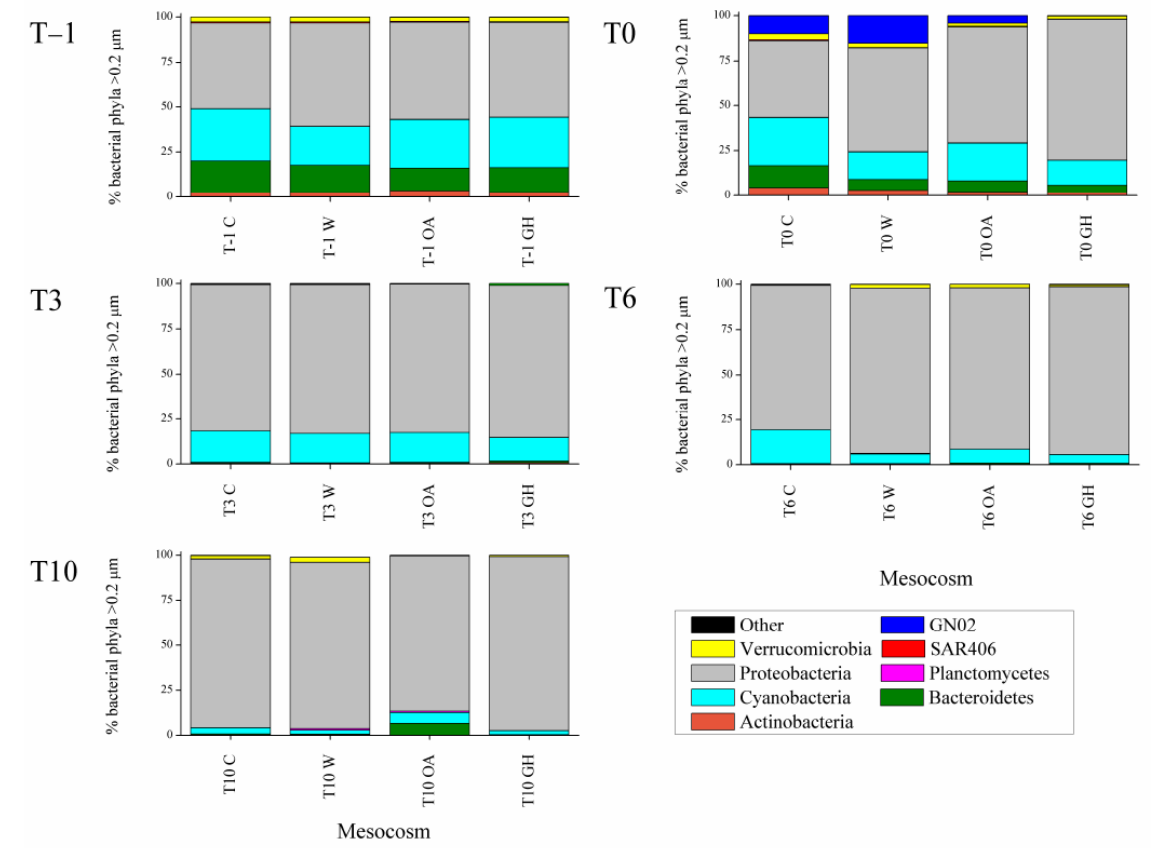
Figure 1. The abundances of ( a ) heterotrophic bacteria (cells mL − 1 ) and (( b ) Synechococcus Figure 1. Percentage contribution of bacterial phyla (>0.2 μ m fraction) in the mesocosms at T – 1, ( Synechococcus , cells mL − 1 ) in the mesocosms at T–1, T0, T3, T6 and T10. Colored asterisks above T0, T3, T6 and T10. “Other” phyla include Acidobacteria, Chlorobi, Chloroflexi, Firmicutes, Gem- symbols denote significant differences from the controls. For the treatment abbreviations, please refer matimonadetes, NC10, Nitrospirae, Spirochaetes and ZB3. C: control mesocosms, W: mesocosms to Figure 2. where the temperature was increased by 3 °C (labeled after warming), OA: mesocosms where the pH was decreased by 0.3 units (labeled after ocean acidification), GH: mesocosms where the tem- perature was increased by 3 °C and the pH was decreased by 0.3 units (labeled after greenhouse).